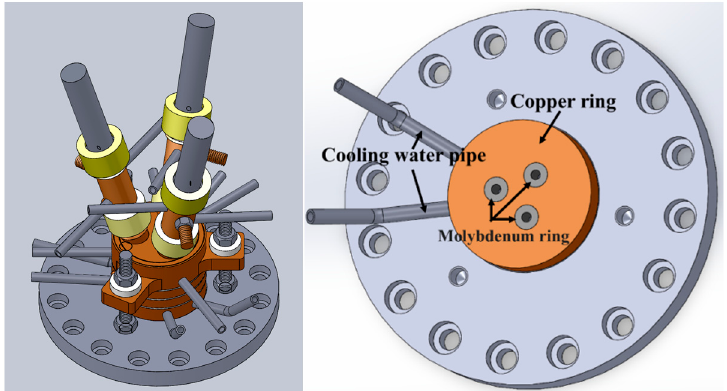
Figure 2. Schematic drawing of a three-channel cascaded arc plasma source and its anode flange for HIT-PSI.